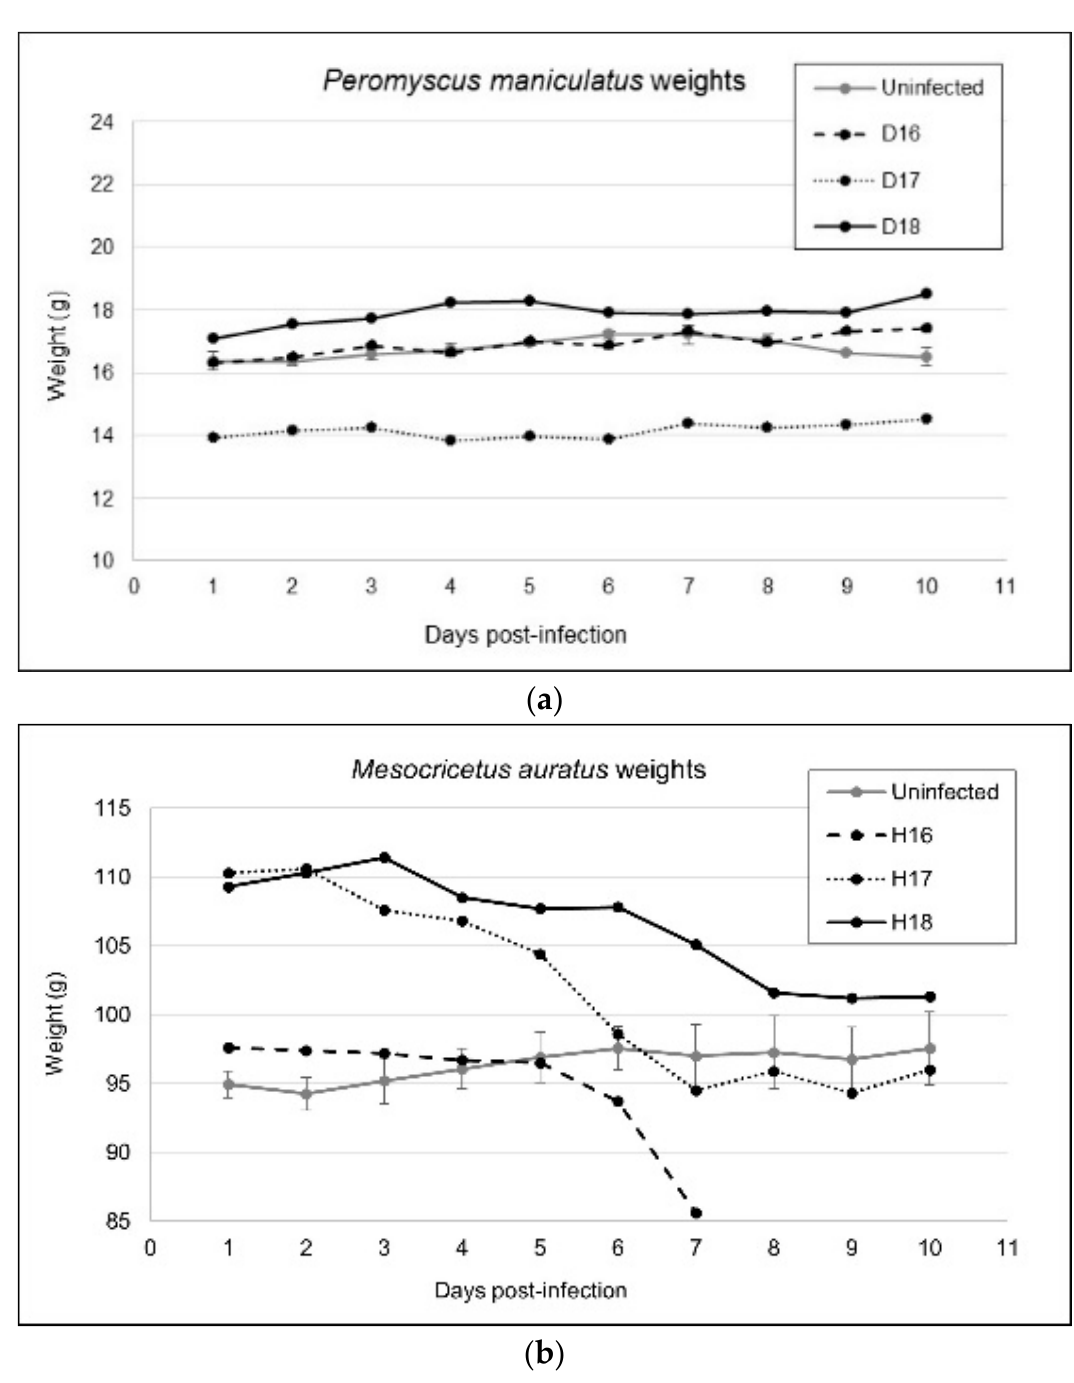
Figure 1. Weight gain or loss in ( a ) Peromyscus maniculatus and ( b ) Mesocricetus auratus over the experimental period. Each datapoint represents the weight for a particular infected individual at that timepoint or the mean (+/ − SEM) weight of two mock-infected individuals at the same timepoint.